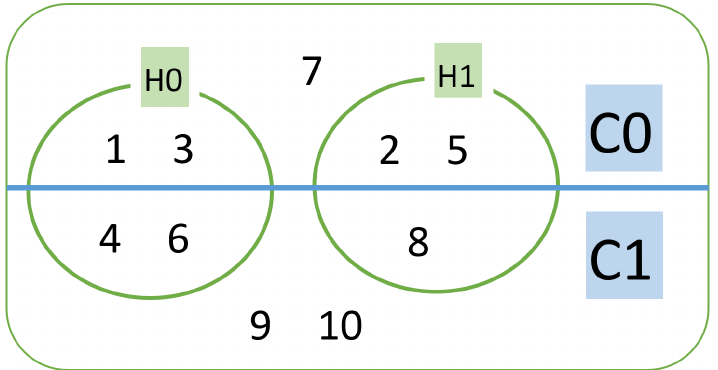
Figure 9. Illustration of intersection of Kmeans and Hierarchical Density-Based Spatial Clustering of Applications with Noise (HDBSCAN)